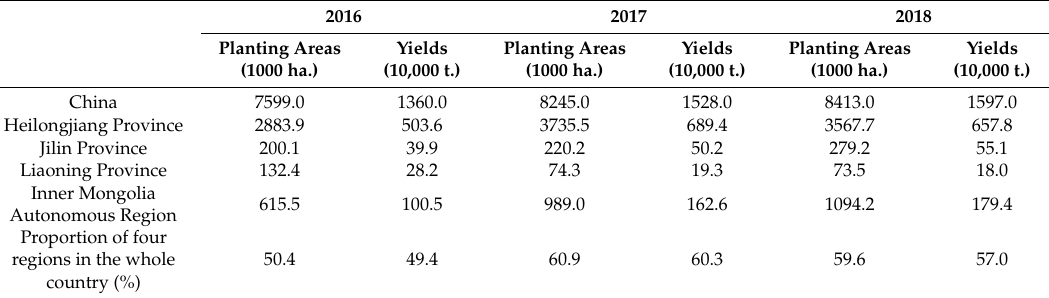
Table 1. Soybean planting areas and yields in China.